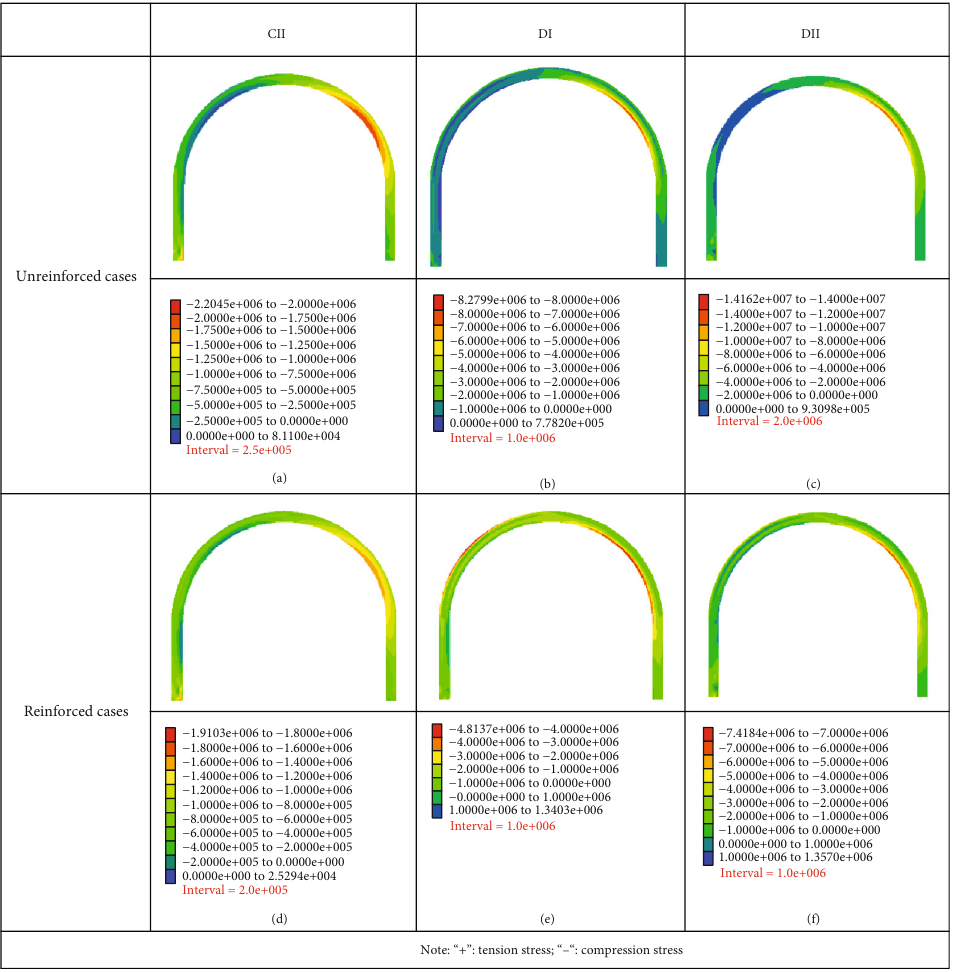
Figure 10: Axial stress distribution on lining concrete for tunnel constructed by FM (unit: